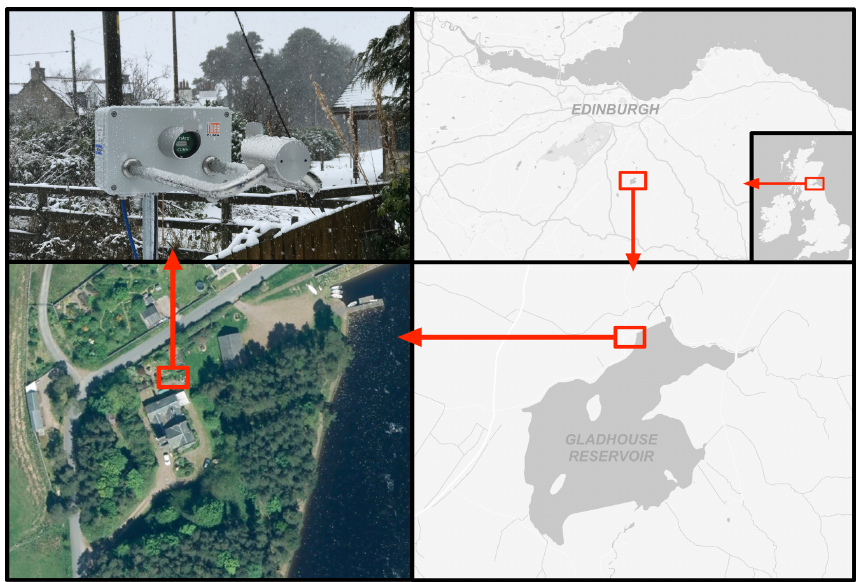
Figure 7. Maps, satellite images, and ground images of the disdrometer location and setup for winter storm Doris at Gladhouse Reservoir House, Scotland. Map data © 2018 GeoBasis-DE/BKE (© 2009), Google. Satellite image: copyright © 2012–2016 Apple Inc. All rights reserved.